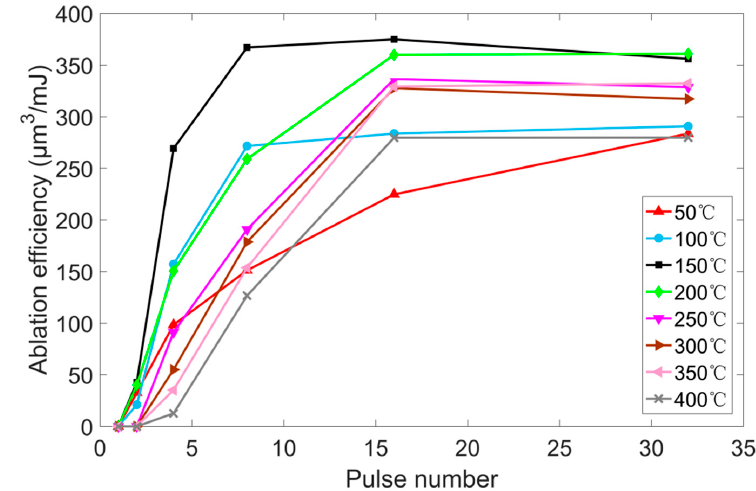
Figure 15. Ablation efficiency ω of different pulse number.